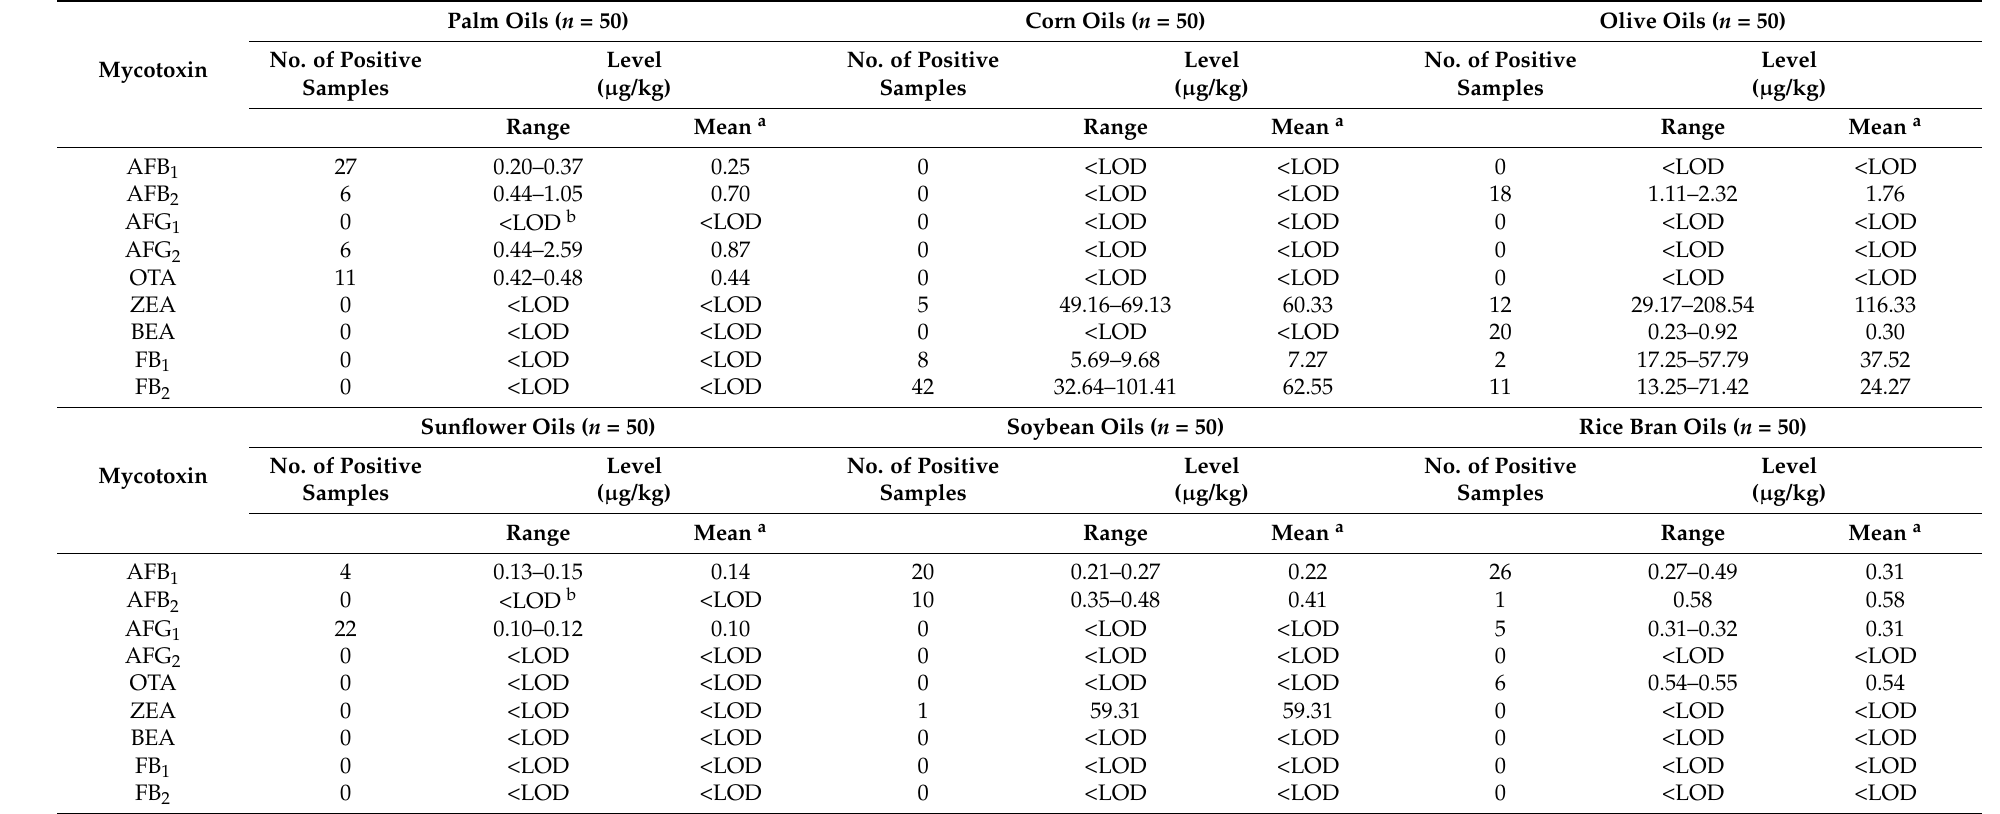
Table 4. Occurrence of nine mycotoxins in edible vegetable